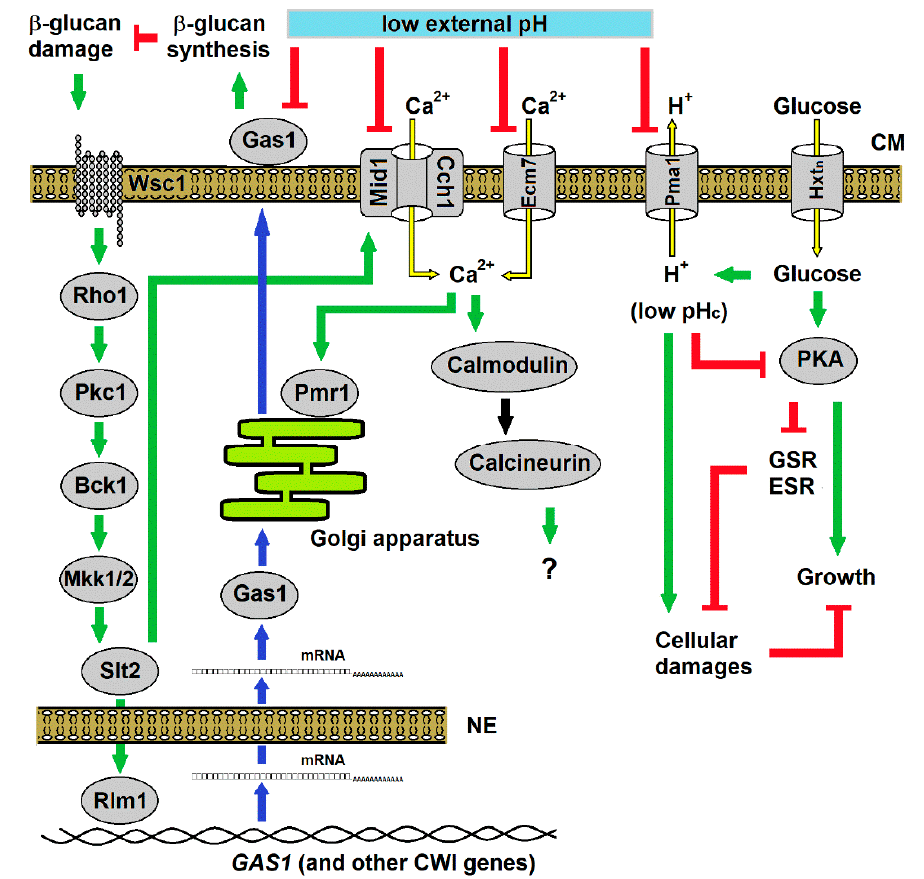
Figure 9. Biological model proposed for the yeast response to stress caused by inorganic acids. Low external pH (pH ex ) inhibits the action of the β -1,3-glucanosyltransferase Gas1p, resulting in damage to the cell wall β -glucan layer. The damage signal is transduced to PKC pathway through the nanomechanical sensor Wsc1p to activate the cell wall integrity (CWI) genes, including GAS1 . In parallel, this pathway induces Ca 2 + uptake by Slt2p-mediated activation of the Mid1p / Cch1p channel, and the imported Ca 2 + triggers the activation of calcineurin pathway whose function in acid response still unknown. However, Ca 2 + uptake is counteracted by the inhibitory action low pH ex on Ca 2 + channels. In consequence, limitation of Ca 2 + influx jeopardises the activation of the P-type ATPase ion pump Pmr1p responsible for transport of Ca 2 + and Mn 2 + to the Golgi apparatus, ions that are necessary for protein processing and tra ffi cking through the secretory pathway, such as those involved in cell wall maintenance and repair. Low pH ex also inhibits the H + e ffl ux pump Pma1p, resulting in the decrease of the cytosolic pH (pH c ) by the lack of extrusion of H + produced by glucose metabolism. Hence, low pH c reduces the PKA pathway [1,9], causing reduction or impairment in cell growth and release of general stress response (GSR) or environmental stress response (ESR) that work for repairing the cellular damages and maintain cell survival. Symbols refer to flux of molecules (yellow arrows) through transmembrane transporters in the cell membrane (CM), activations (green arrows) or inhibitions (red T-shaped lines) within regulatory pathways, and the genetic flux (blue arrows) from gene transcription, mRNA transport across the nuclear envelope (NE) to the cytosol and protein for translation protein and tra ffi cking inside the Golgi apparatus to outer face of CM.